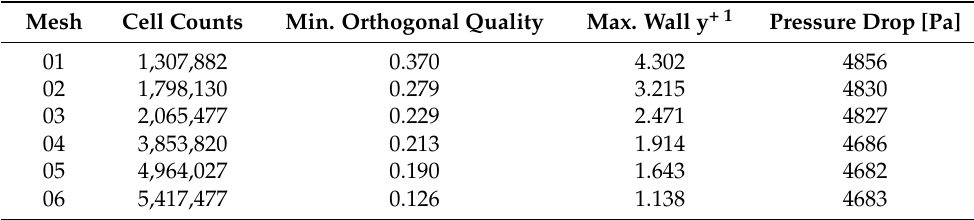
Table 3. Mesh refinement levels.